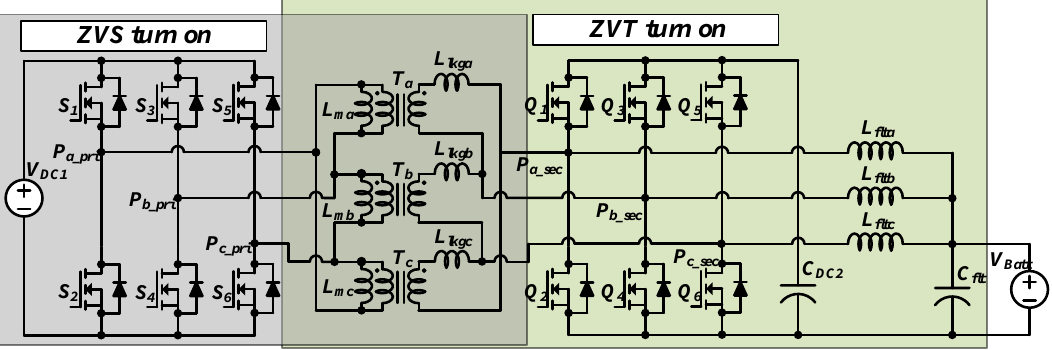
Figure 1. Configuration of the 3-phase current fed dual active bridge (3P-CFDAB) converter.